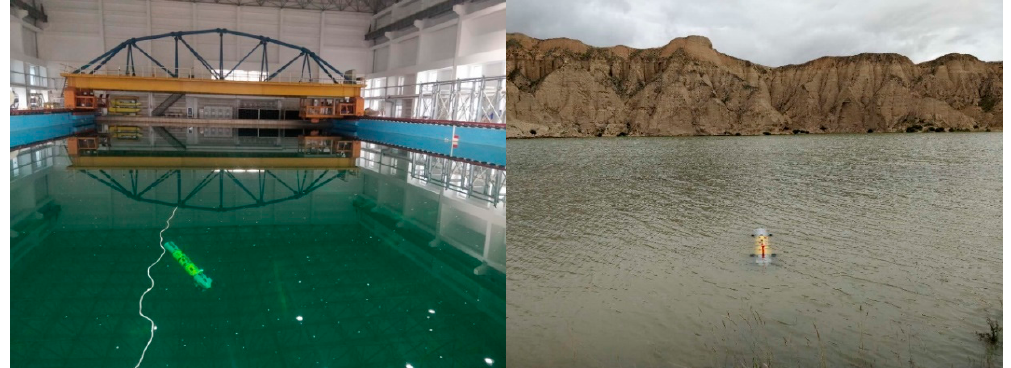
Figure 14. Experiment sites in the tank (left) and on the Tibetan Plateau (right).